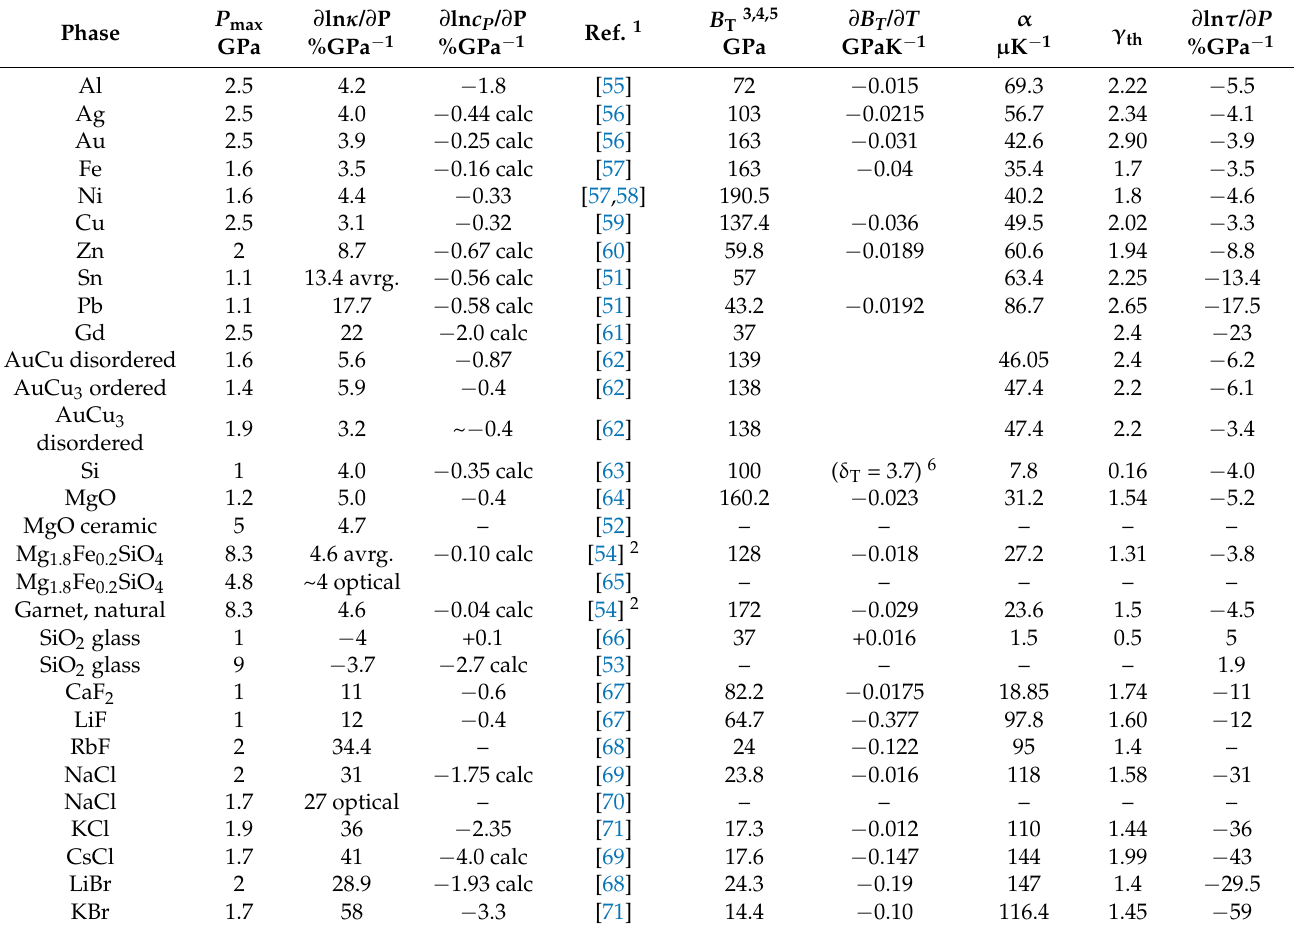
Table 3. Pressure dependence of thermal conductivity at ~298 K for L ~mm plus relevant thermodynamic data and lifetimes calculated from transport